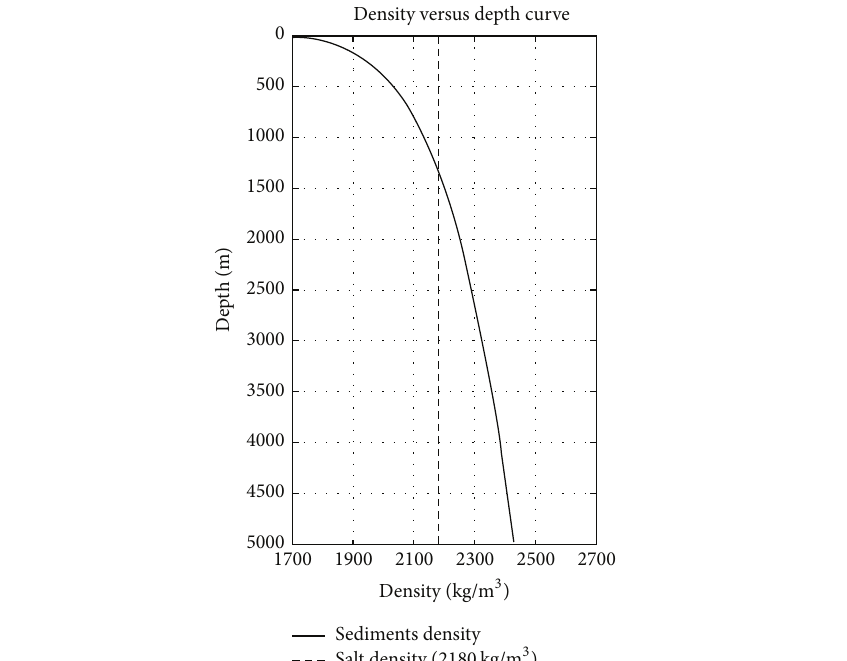
Figure 3: Density versus depth curve, representative of sediments of Gulf of Mexico and rock salt density. Based on Nelson and Fairchild [14].